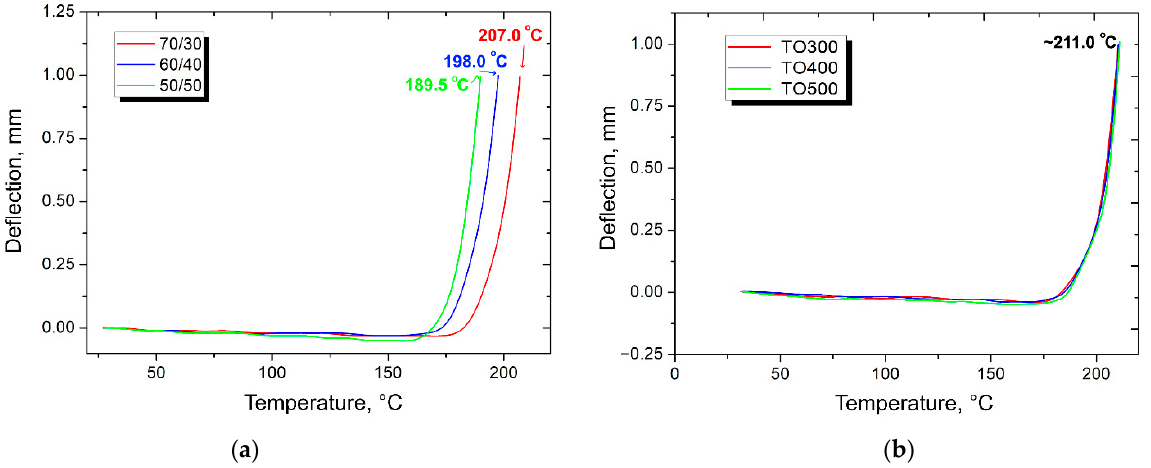
Figure 11. HDT curves of composites reinforced with ( a ) initial CF and ( b ) CF after surface modification (fiber content of 50 wt. %).